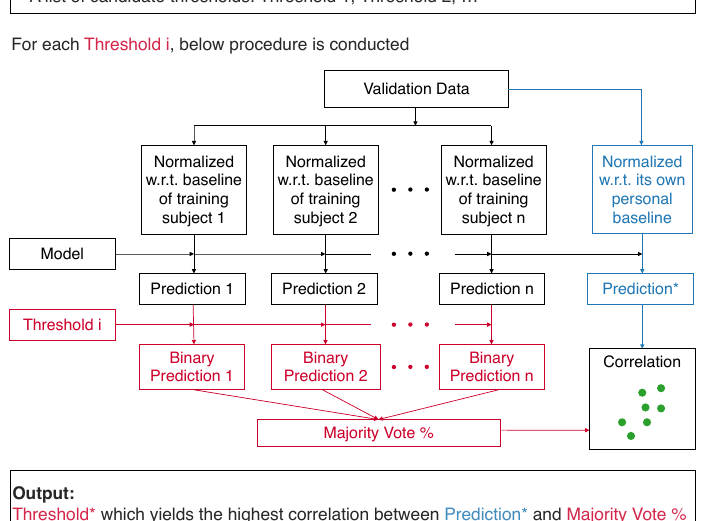
Figure 2. The Optimized Aggregation of Predictions framework. From a list of candidate thresholds, the one which maximizes the correlation between the predictions made by the trained model on the validation data normalized with reference to its own personal baseline (Prediction*, denoted by blue) and the aggregated binary predictions made by the same model on the validation data standardized using the normalization factors of different training subjects (Majority Vote %, denoted by red) is chosen to be used for converting the prediction scores to binary predictions on the test data.